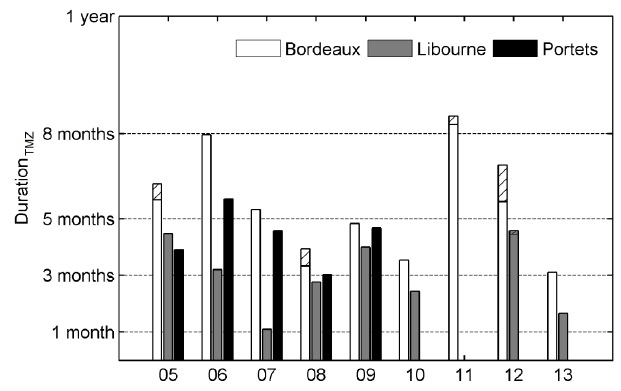
Figure 6. Duration of the TMZ presence per year at the three tidal rivers stations. Striped bars designate the duration of the TMZ when it appears in winter: 17, 18, 9 and 39 days respectively in the years 2005, 2008, 2011 and 2012 at Bordeaux; 6 days in the year 2012 at